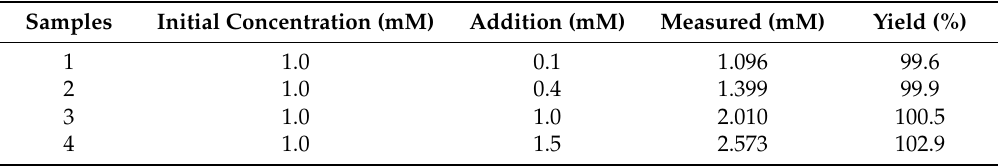
Table 1. Amperometric response against the addition of different amounts of H 2 O 2 into a 1 mM H 2 O 2